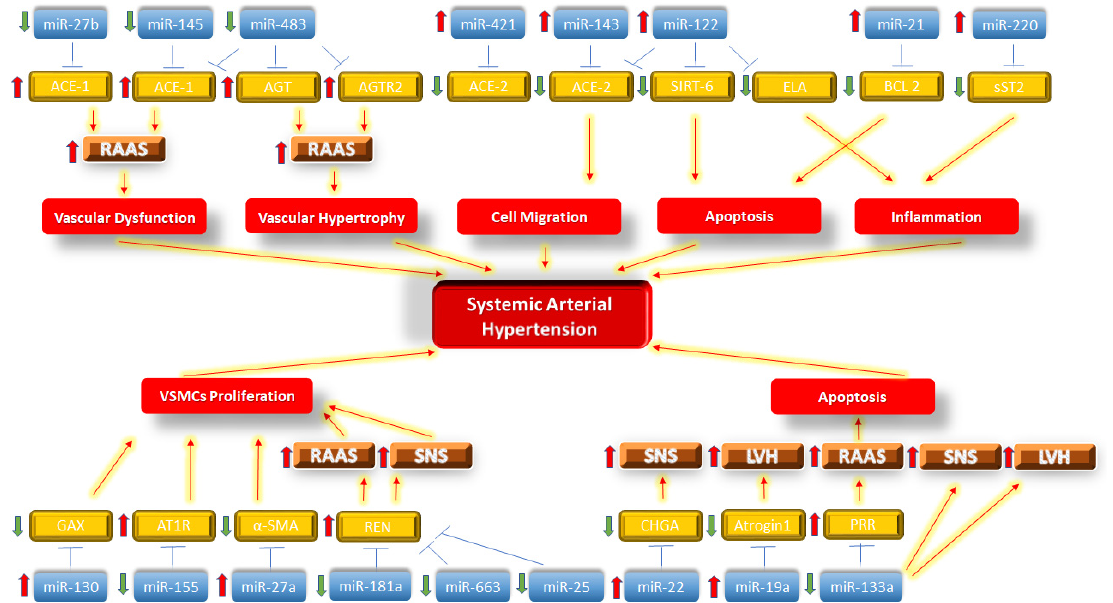
Figure 1. Schematic representation of miRNAs regulating genes and signaling pathways in RAAS, SNS and LVH in SAH. Thick red upward arrow: upregulation of miRNA or target gene; thick green downward arrow: downregulation of miRNA or target gene; blue thin arrow: indicates that miRNA regulates that gene; red thin arrow: indicates that the change in the signaling pathway promotes a specific outcome.